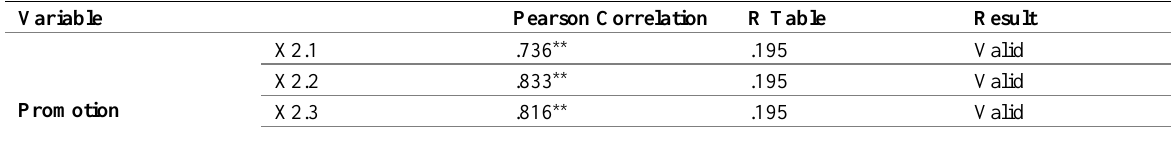
Table 3: Promotional Attractiveness Validity Test Results